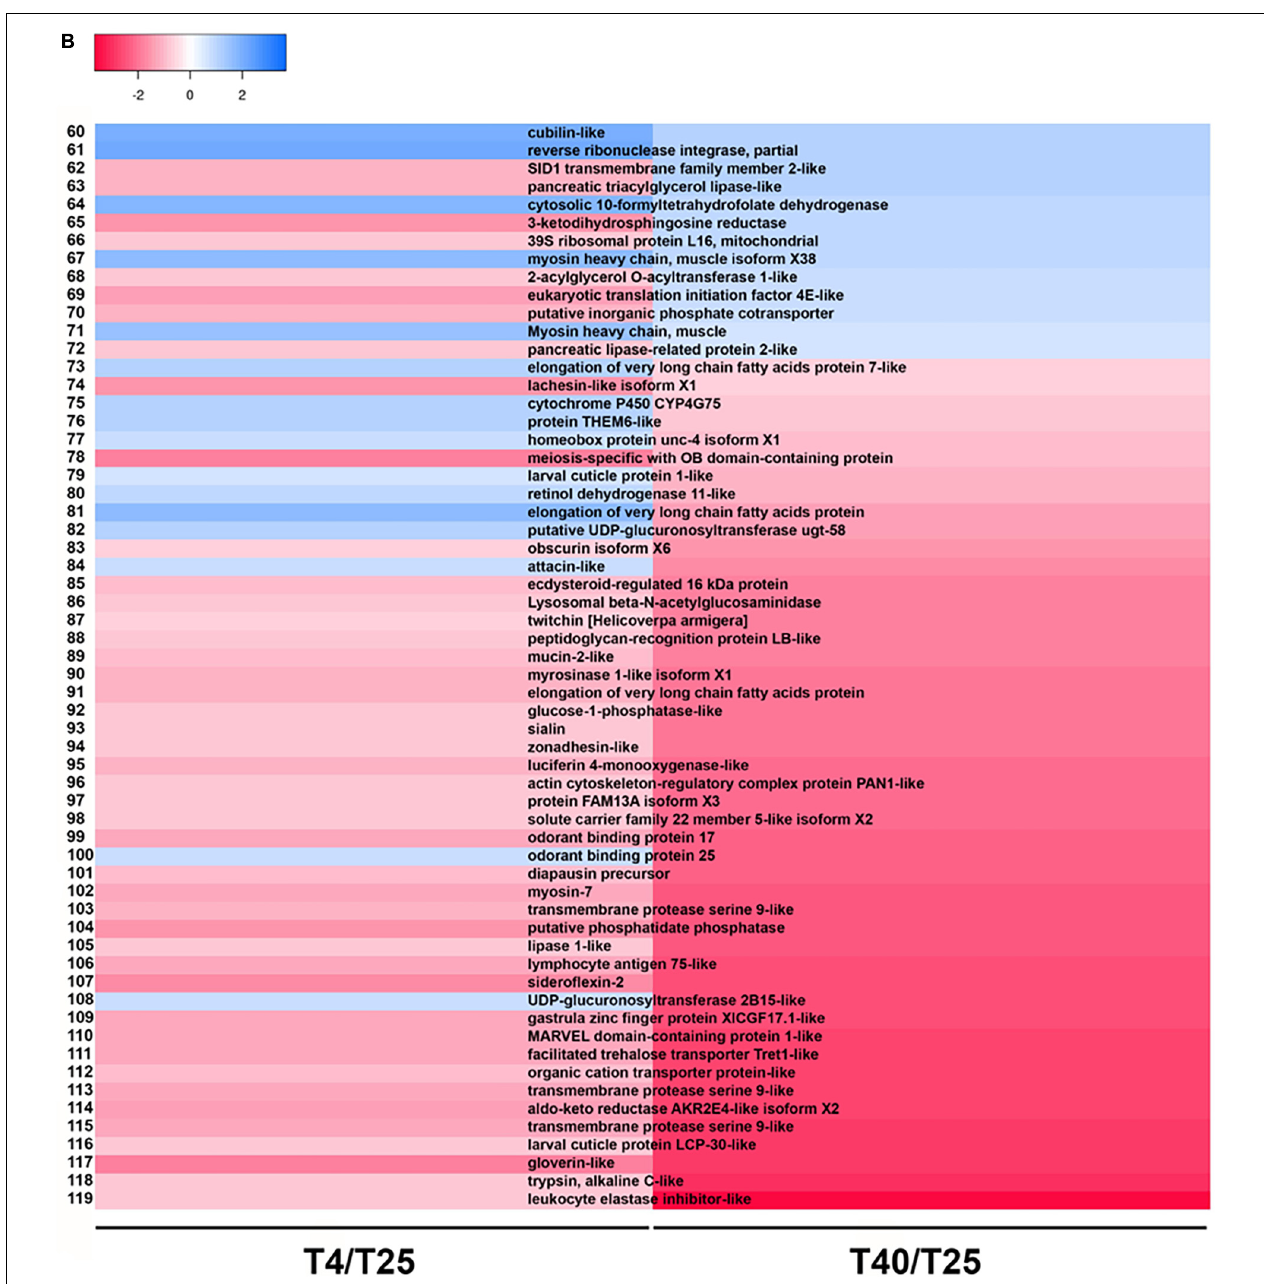
FIGURE 6 | Distribution of same differentially expressed genes (DEGs) between treatment groups. (A,B) Heatmap shows expression patterns for same DEGs ( P -value < 0.01, log 2 FC ≥ 5, ≤ –5) involved in low (4 ◦ C) and high (40 ◦ C) temperature treatment groups in comparison with T25 as group of control.